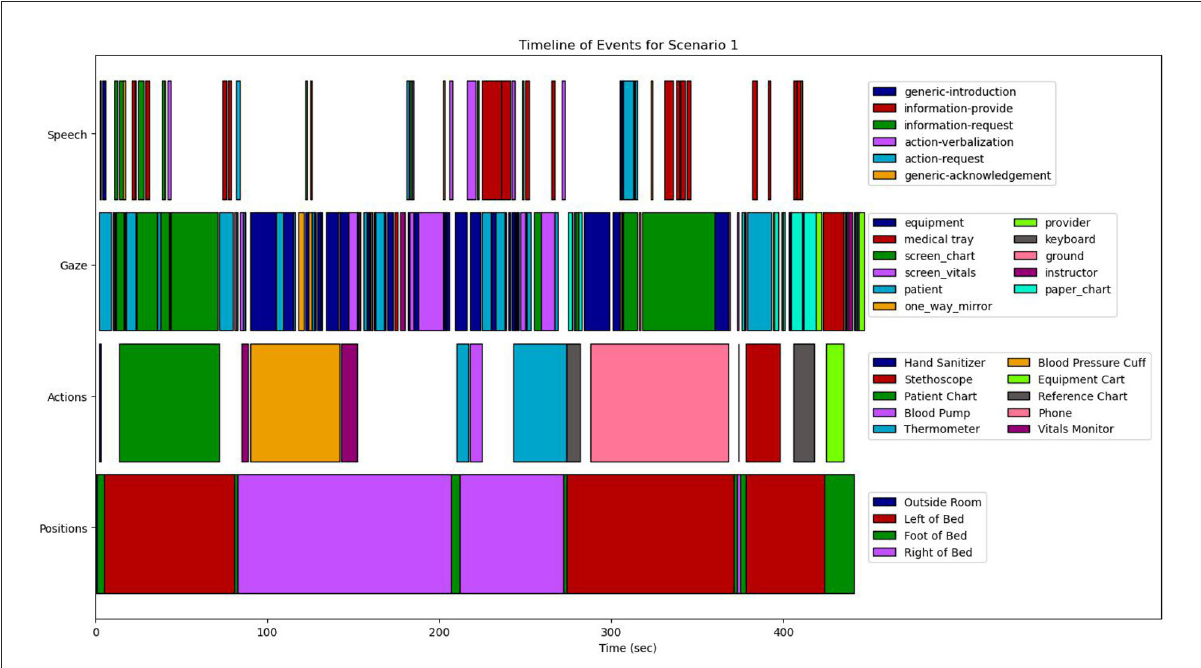
FIGURE9 The complete timeline of events for scenario S1 containing annotated data from participant position, action, gaze, and